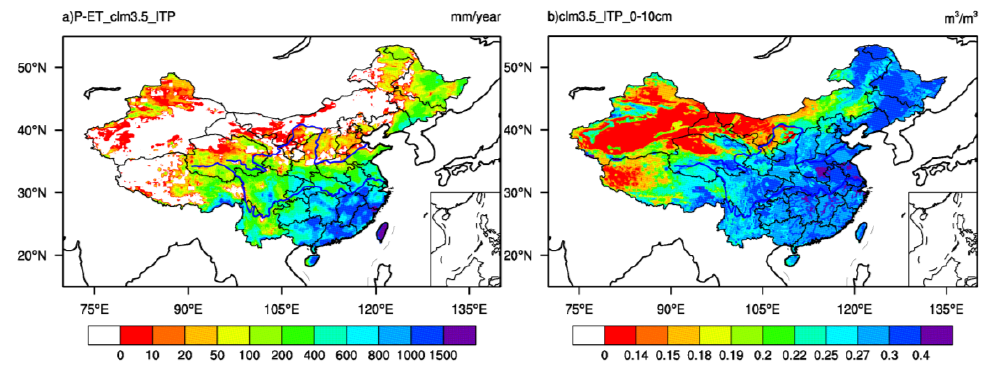
Fig. 10. Comparison between: (a) mean precipitation minus simulated evapotranspiration ( P –ET); and (b) simulated mean volumetric soil Fig.10. Comparison between: (a) simulated mean volumetric soil moisture in the 732 moisture in the 0–10cm soil layer averaged for July 2005–June 2010 by CLM3.5 using ITP 0–10 cm soil layer; and (b) mean precipitation minus simulated (P–ET) averaged for 733 July 2005 – June 2010 by CLM3.5 using ITP forcing. 734